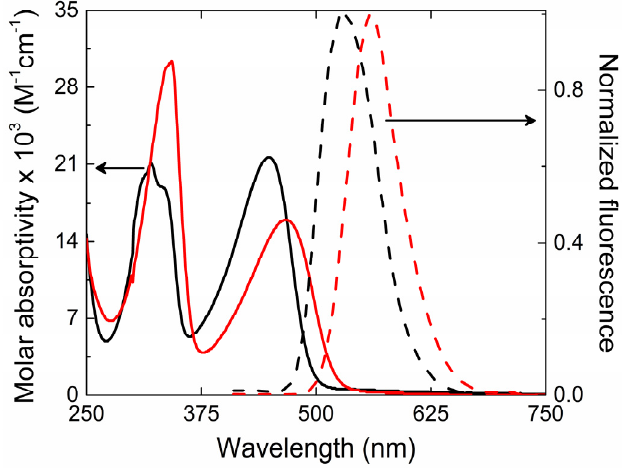
Figure 1. The solid and dashed lines show the linear absorption and fluorescence spectra for the PFeBT (black lines) and PFeBSe (red lines) polymers.